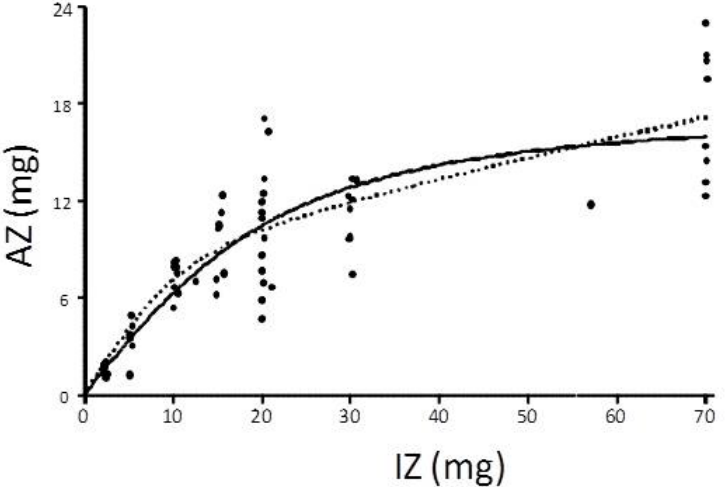
Figure 1. The individual measurements of absorbed Zn (AZ) vs ingested Zn (IZ), one time doses given in the post-absorptive state, and the fitted Hill Equation model (thick solid line). The model predicts the absorption, approaching the A max value of 13 mg (dashed line).